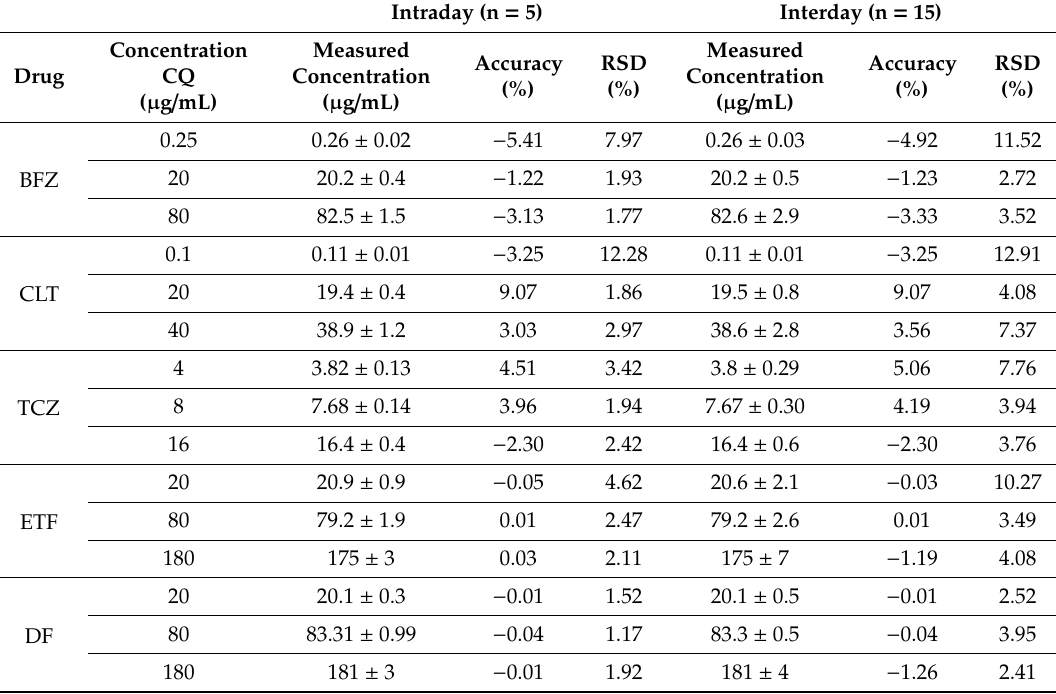
Table 8. Intraday and interday accuracy and precision results for all drugs. Results are expressed as mean ± SD (n =